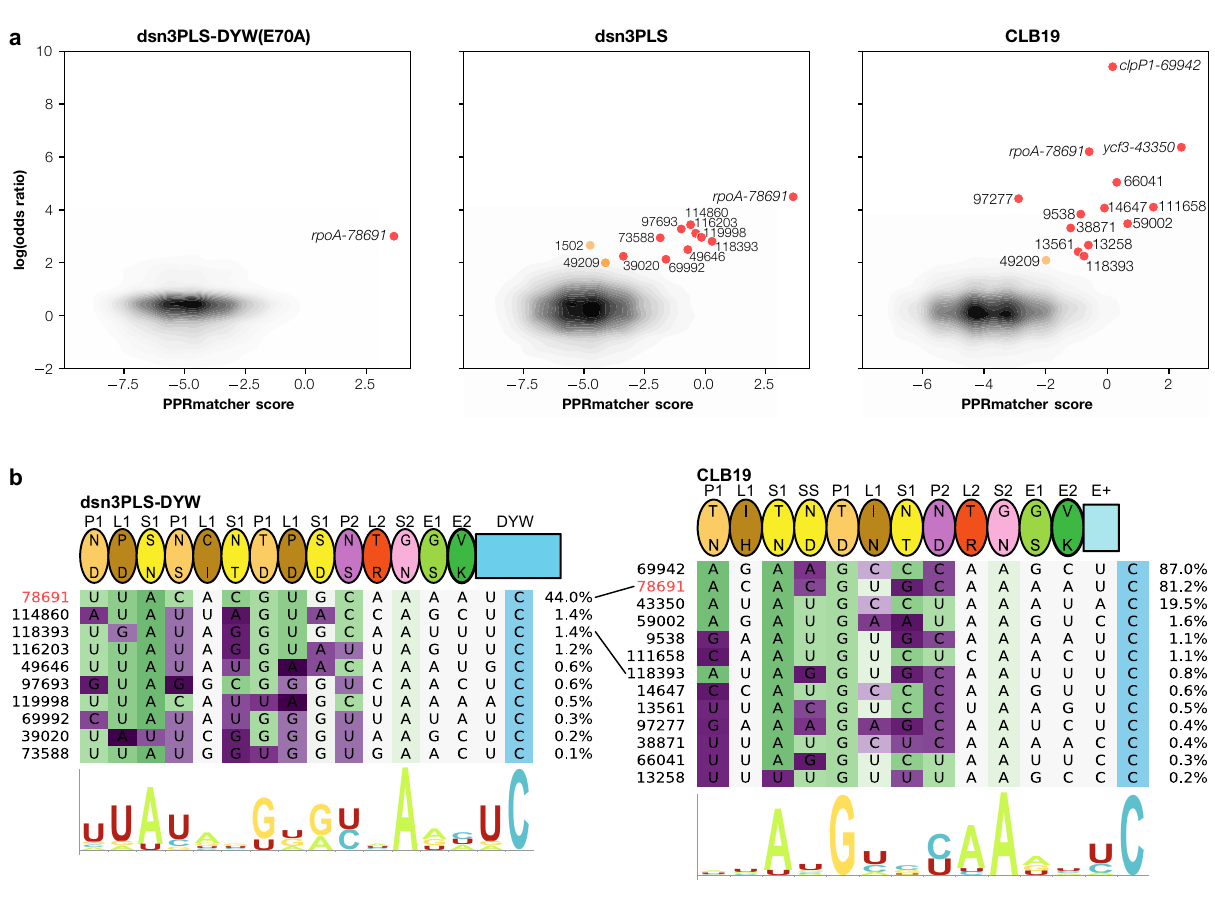
Fig. 4 Putative off-target editing by dsn3PLS-DYW and CLB19. a Potential editing sites plotted by their predicted binding to the expressed editing factor ( x -axis) against the ratio of the editing activity compared to a negative control (expressed as the log of the odds ratio). Predicted binding scores were calculated with PPRmatcher (https://github.com/ian-small/PPRmatcher). For dsn3PLS(E70A) the negative control was clb19 , for dsn3PLS-DYW and CLB19, the negative control was dsn3PLS(E70A). All sites where the difference in editing is statistically signi fi cant (Fisher exact test corrected for multiple testing) and the log(odds ratio) is greater than 2 are highlighted in red (or orange for two potential ‘ false positives ’ discussed in the text). The ~32,000 sites below this threshold are indicated by the density contours (grey-black). b Alignment of the highlighted sites from a with the corresponding editing factor. The rpoA-78691 site is highlighted in red. The target sites are coloured according to the PPRmatcher score at each position, from favoured (green) to neutral (white) to disfavoured (purple). The percentage of edited transcripts at each site is indicated on the right. The sequence logos (constructed by Skylign 59 ) indicate the nucleotide biases at each